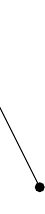
Figure 5. Partial Order Structure of Example 5KS.